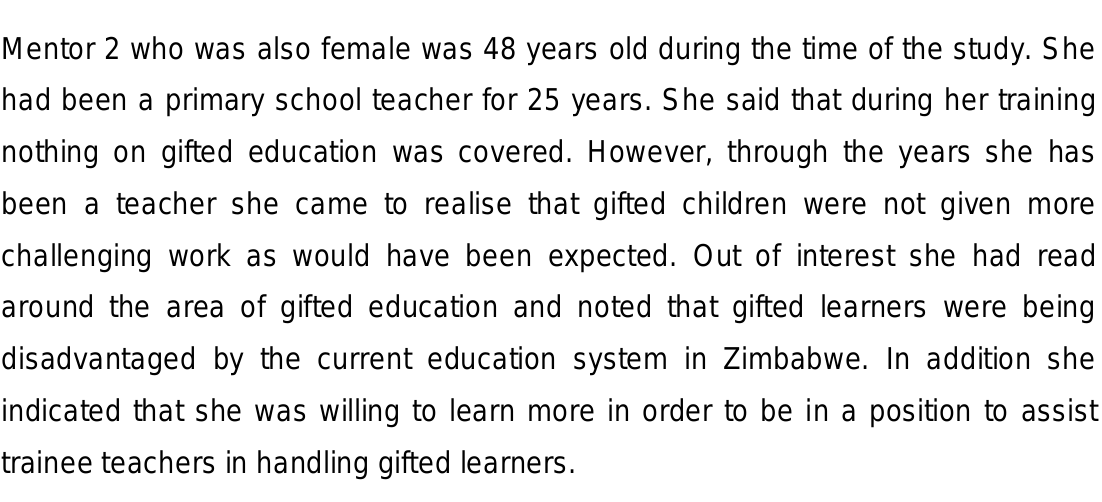
Table 4.3: A breakdown of the participants from which the qualitative data was collected. The study collected data from a sample 25